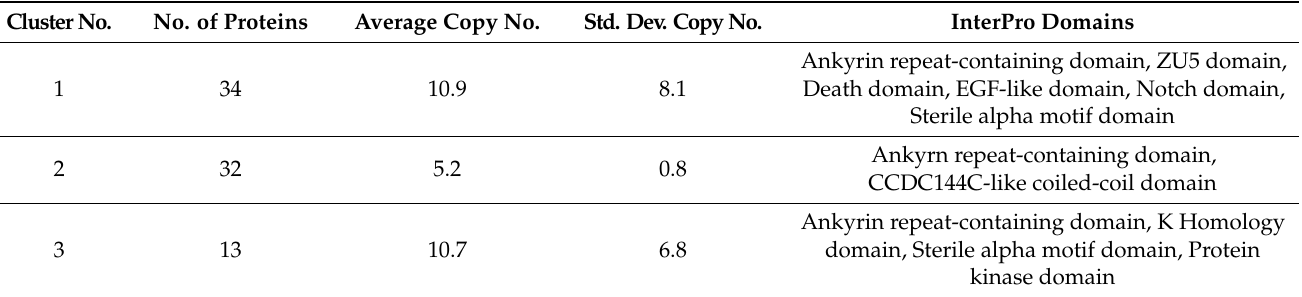
Table 1. Top 10 clusters obtained using CD-HIT and their domain information. Cluster